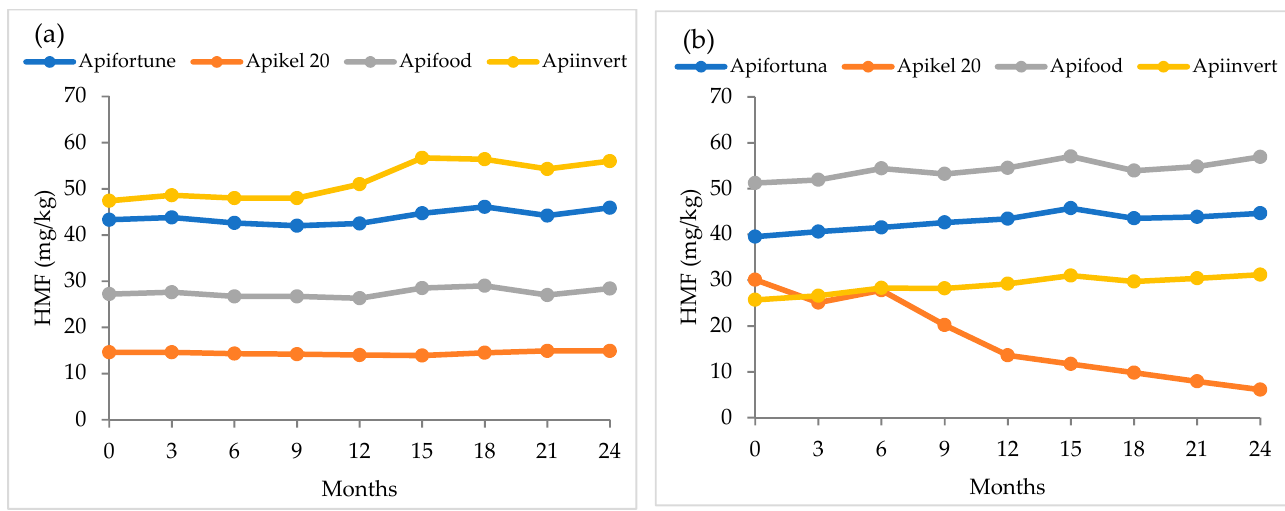
Figure 2. Changes of HMF content in syrups during storage at 10–14 °C ( a ) from 2012 and ( b ) from 2013. Storage at the temperature of ca. 4 °C resulted in an increase in HMF content in starch syrups (Apifortune, Apifood) and the inverted saccharose syrup (Apiinvert) from both years not exceeding 10% after 24 months of storage (Figure 3). Again, the starch syrup